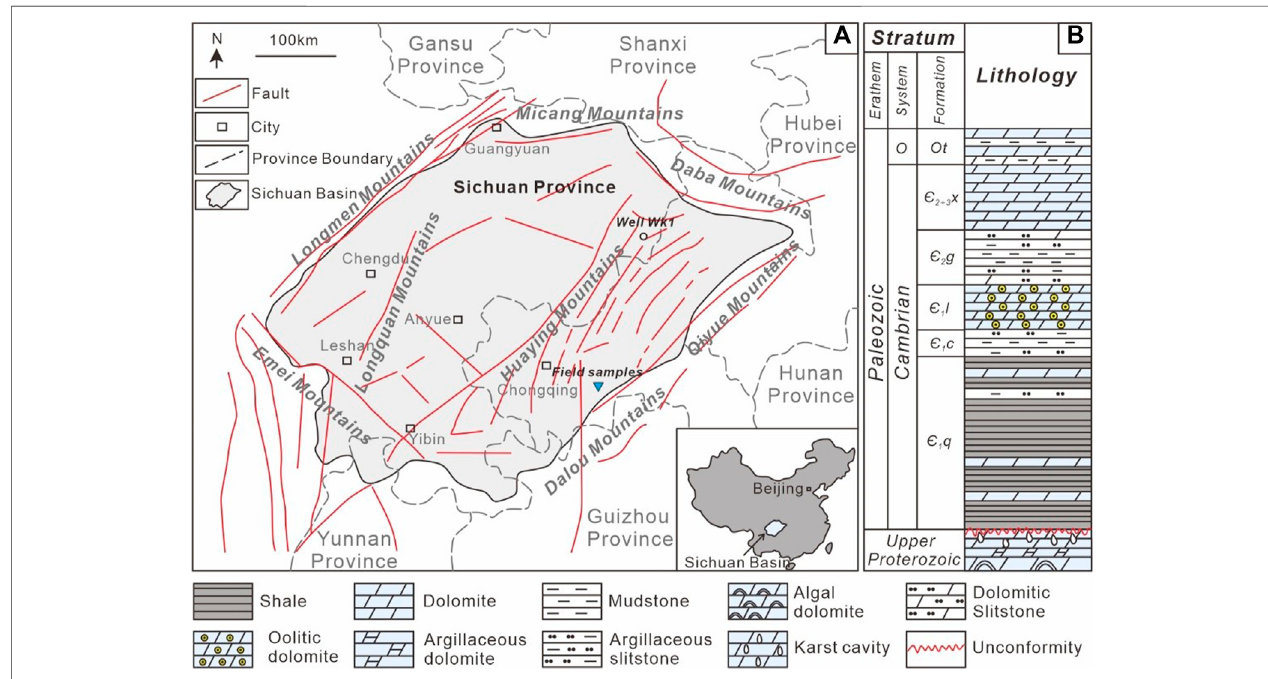
FIGURE 1 | Map of the study area showing (A) the locations of the collected fi eld samples and drilled wells and (B) the general stratigraphic framework of the investigated Middle – Upper Cambrian Xixiangchi Formation (after Su et al., 2022).